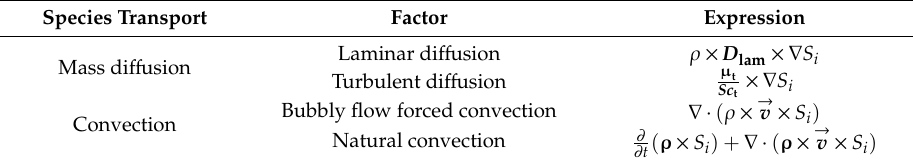
Table 4. Factors that a ff ect the tracer homogenization in the mathematical